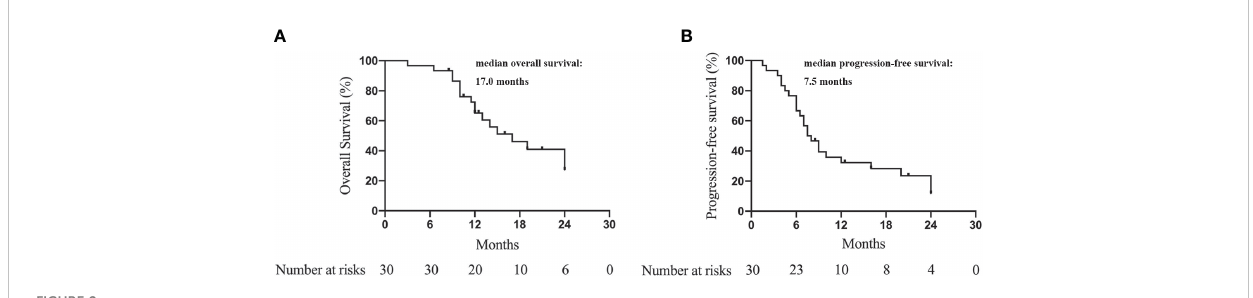
FIGURE 2 Kaplan-Meier curves to show the overall survival (A) and progression-free survival (B) of advanced ICC patients treated with camrelizumab and